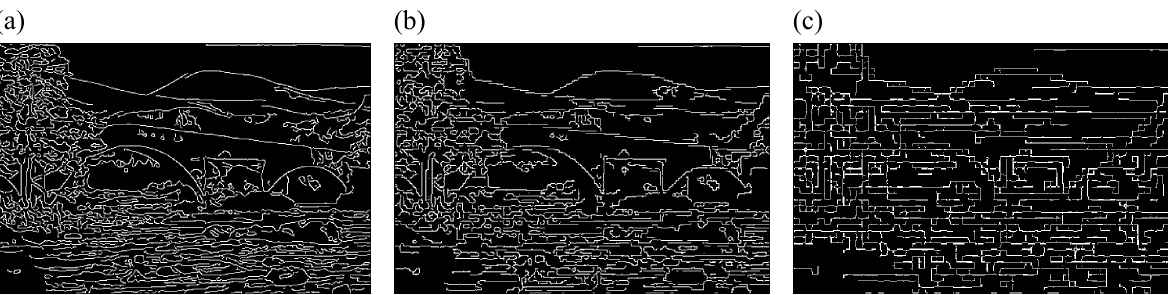
Fig. 11. The example of an image with HD where the Canny edge detection operator was applied to three levels of decomposition for the Haar wavelet transformation. (a) Level 1, (b) Level 2, (c) Level